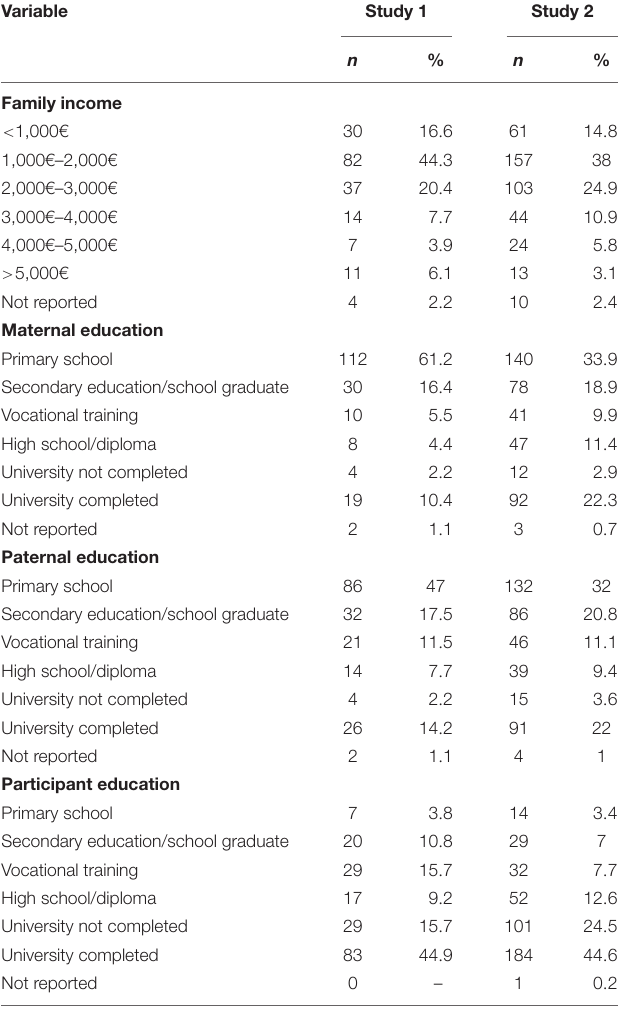
TABLE 1 | Distribution of the participants socioeconomic status (educational and income levels) in Studies 1 and 2. Variable Study 1 Study 2